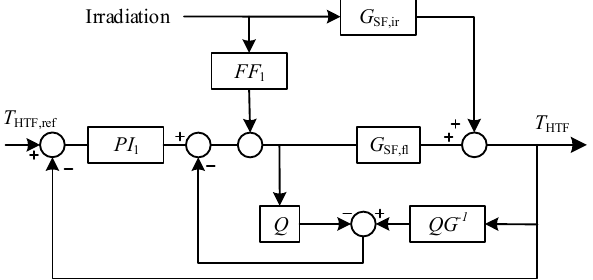
Figure 8. Block diagram of disturbance observer-based feedforward–feedback control scheme of the SF subsystem.